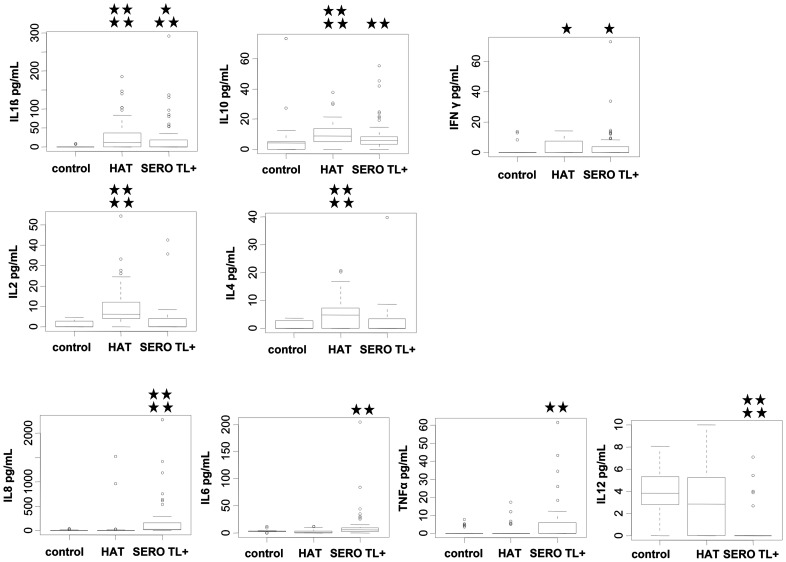
Plasmatic cytokine profiles in HAT patients, SERO TL+ subjects, and endemic controls.Box plots of cytokine concentration are presented. Boxes represent the medians and interquartile ranges and whiskers represent 10th and 90th percentiles. Asterisks indicate significant differences over the control group: ****, p<0.0001; ***, p<0.001; **, p<0.01; *, p<0.05 (nonparametric Wilcoxon signed-rank test). Only cytokines with significant differences are shown. Group effectives: control (n = 40); HAT (n = 52); SERO TL+ (n = 60).